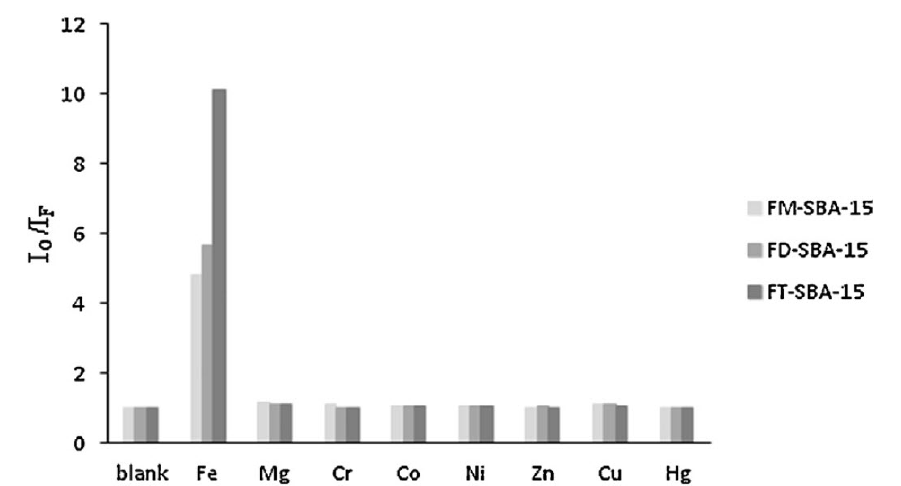
Fig. 12. Bar graphs of the fluorescence emission intensity for 8 different metal ions showing the metal ions selectivity profile of FM-SBA-15, FD-SBA-15 and FT-SBA-15 for each metal ion. I